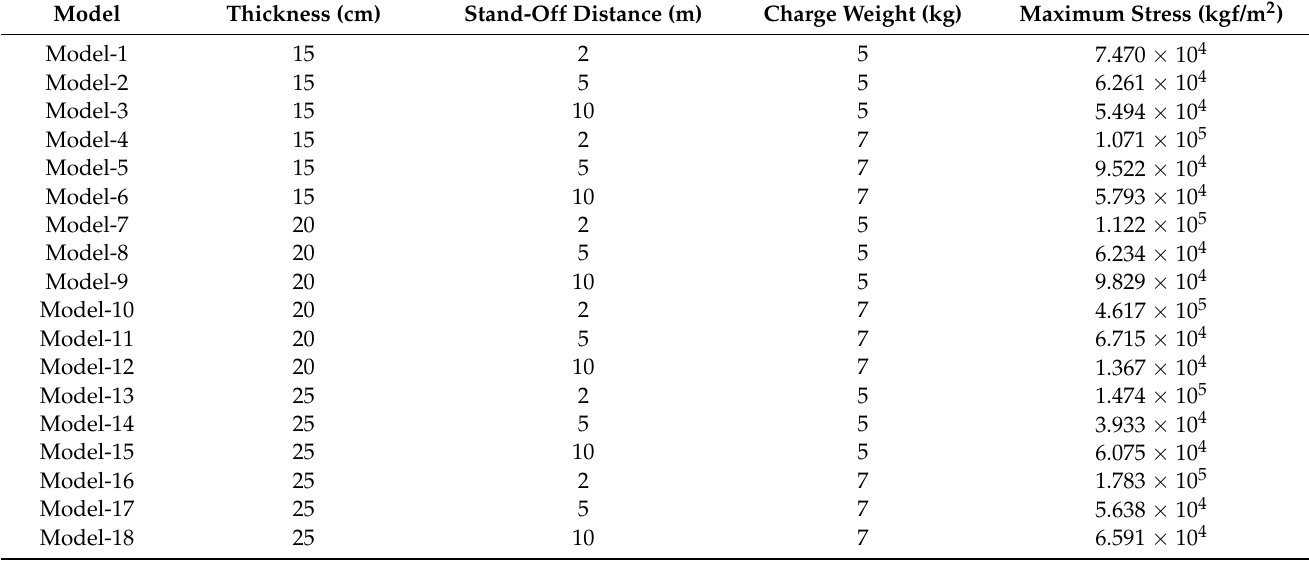
Table 4. Maximum stress values in the